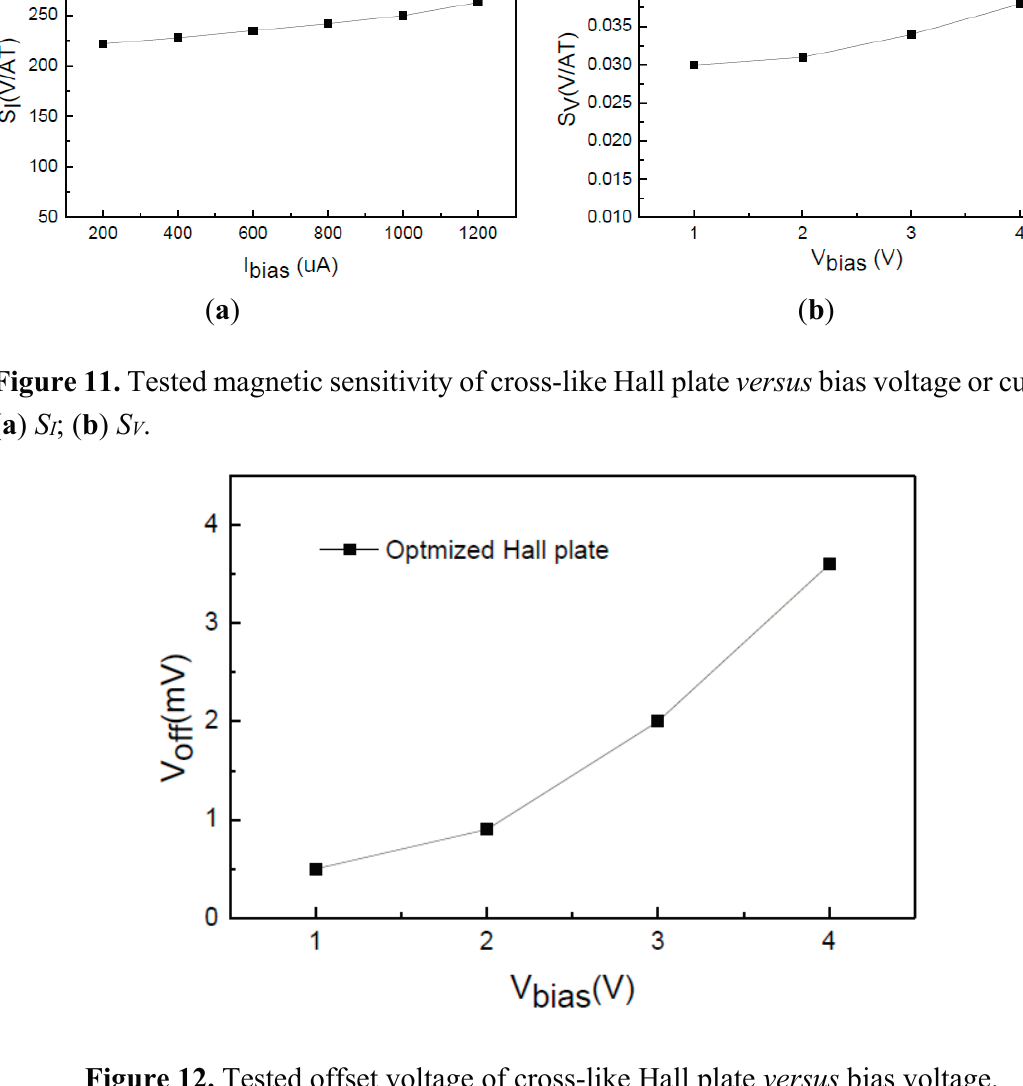
Figure 12. Tested offset voltage of cross-like Hall plate versus bias